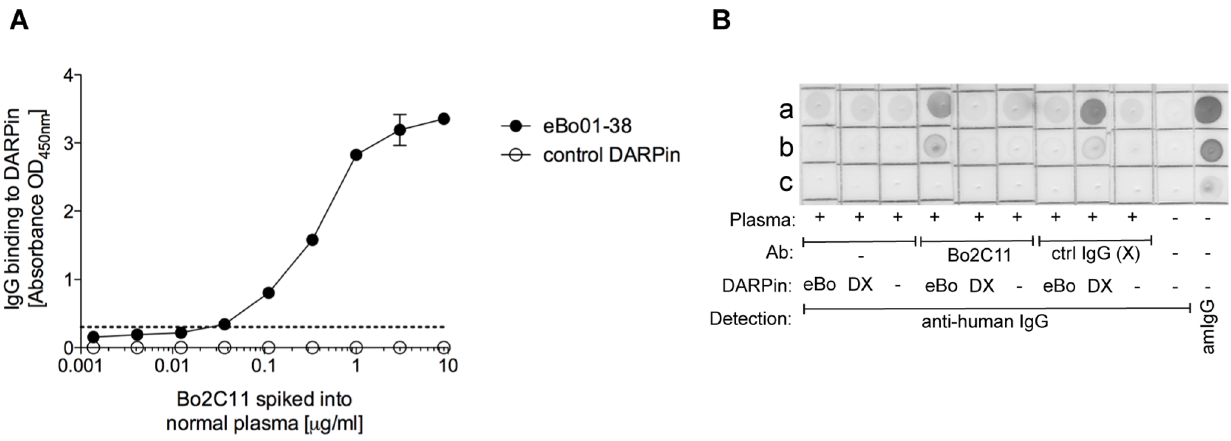
Figure 6. Dimeric DARPins recognize Bo2C11 spiked in healthy plasma. A) Detection of Bo2C11 by DARPins in ELISA. DARPin eBo01-38 (closed circles) or a dimeric control DARPin (open circles) were coated at 69 nM in PBS on a microtiter plate. 3-fold serial dilutions (60 nM – 9.3 pM) of Bo2C11 in a plasma-pool from healthy donors (1:100 in PBS containing 0.15% casein and 0.1% tween-20) were incubated on immobilized DARPins. Bo2C11-binding to DARPins was detected using a horseradish-peroxidase-labeled sheep anti-human IgG antibody. The dotted line represents the detection limit of Bo2C11 in plasma on DARPin eBo01-38 (mean of diluted plasma + 2 SD). B) Catching of Bo2C11 from human plasma with DARPins. An anti-His 6 antibody was dotted at 1 m g (a), 0.1 m g (b) or 0.01 m g (c) to a membrane, respectively. Human standard plasma diluted 1:50 alone or spiked with either 2 m g/ml Bo2C11 (Bo2C11) or a control human IgG (X) was mixed with eBo38-38 (eBo), a DARPin specific for the control IgG (DX) or nothing (-). Complexes of human IgG and DARPins were detected using a peroxidase-labeled murine anti-human IgG antibody. As controls the detection antibody was incubated on the membrane alone and the presence of the anti-His 6 antibody on the membrane was confirmed with a peroxidase-labeled sheep anti-murine IgG antibody (amIgG). and probably a small contamination of dimeric DARPins with monomeric ones (lines 6–8).